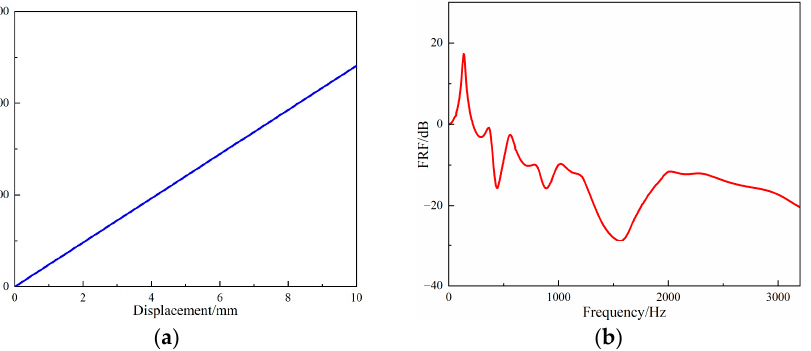
Figure 13. Simulation results of periodic structural support. ( a ) Load-displacement curve of periodic structure support, ( b ) simulation FRF value curve of periodic structure support.